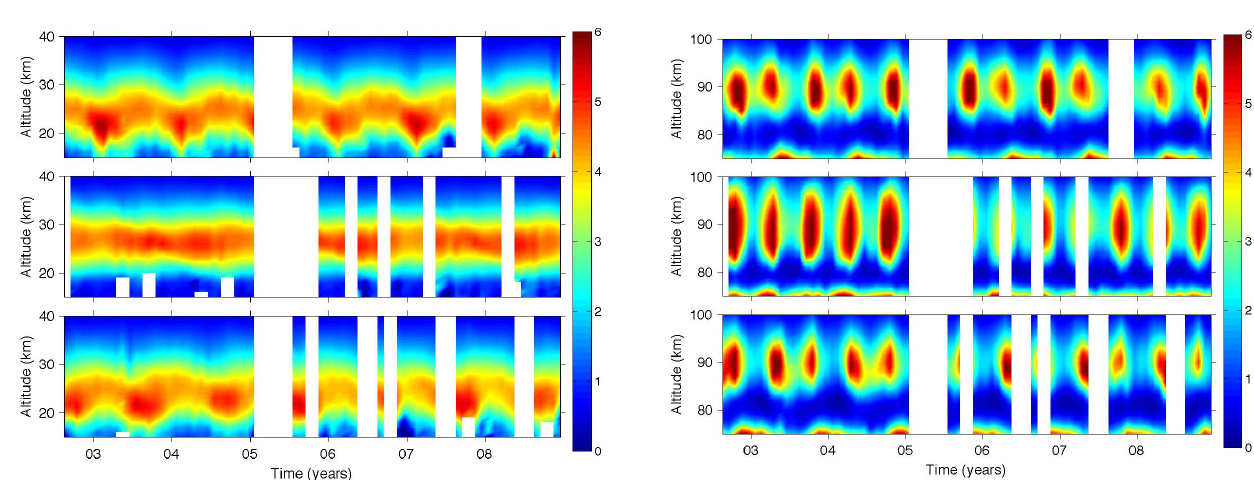
Fig. 5. Monthly ozone number density in the MLT in three latitude belts as a function of time and altitude. The density is scaled by 10 8 cm − 3 . The time covered is 1 August 2002–31 December 2008. Latitude belts: 30 ◦ N–50 ◦ N (top), 10 ◦ S–10 ◦ N (middle), 30 ◦ S– 50 ◦ S